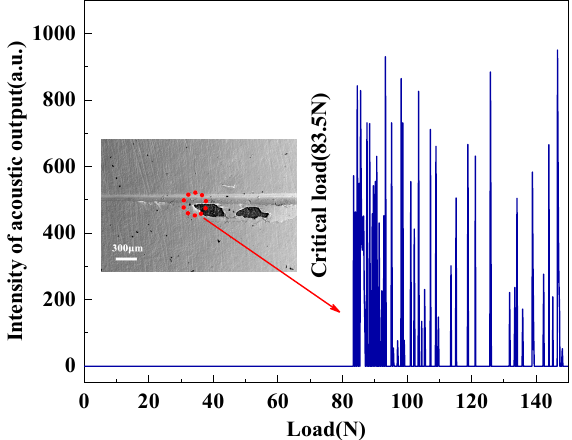
Figure 3. Acoustic emission signal intensity versus load curves of the niobium coating and the corresponding scratch scar morphology (inset).